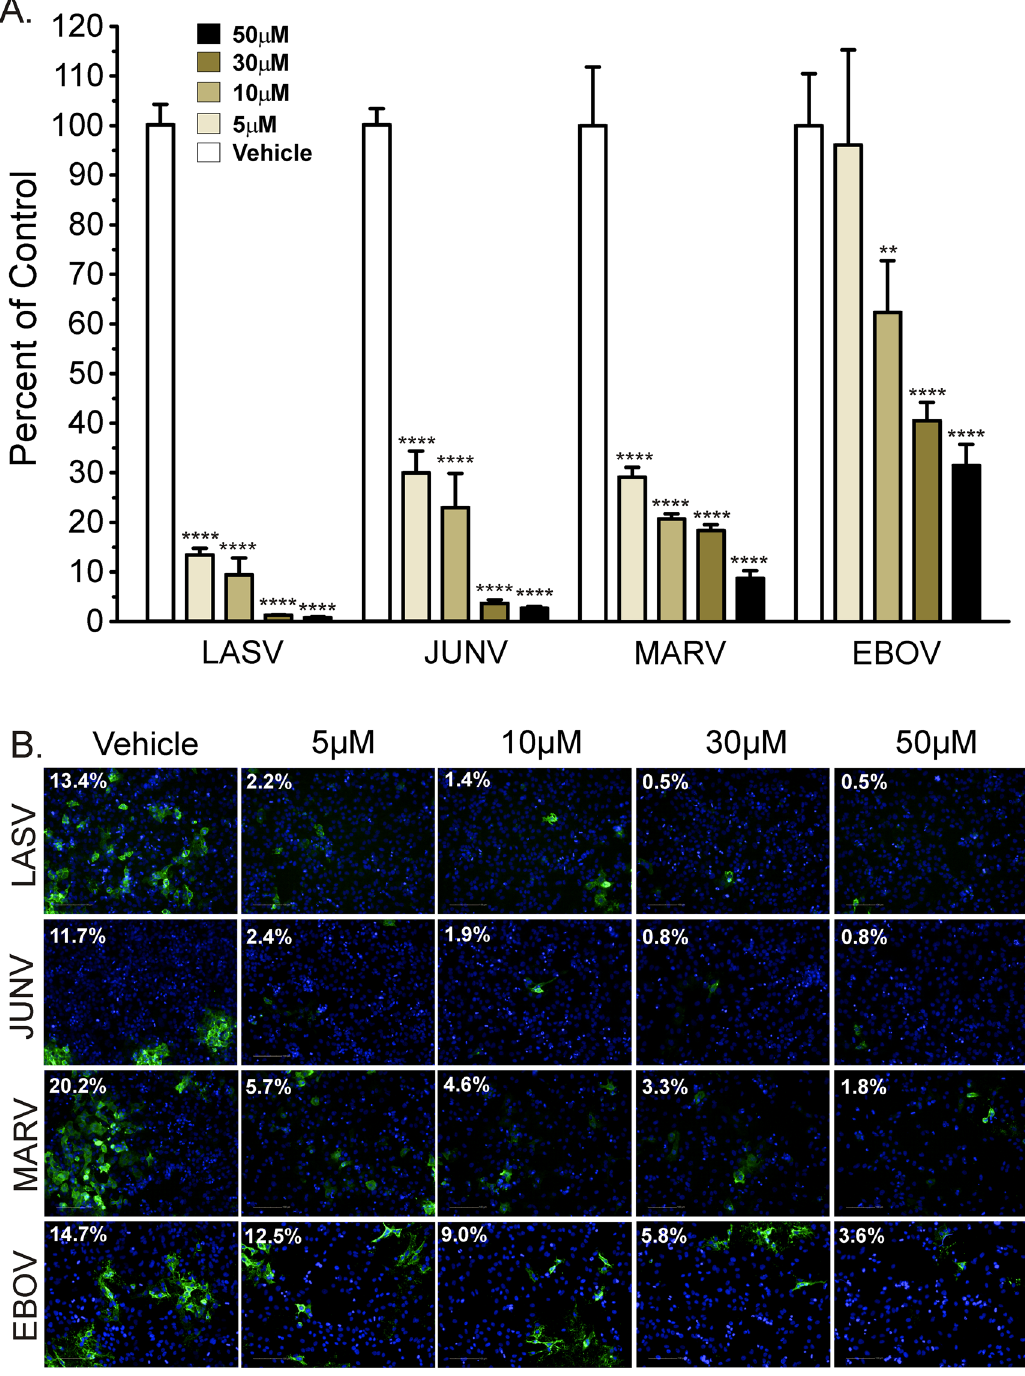
Fig 7. Synta66 inhibits egress of authentic filoviruses and arenaviruses. A . HeLa cells were infected with LASV (MOI 0.01), JUNV (MOI 0.1), MARV (MOI 0.1), or EBOV (MOI 0.1) and treated with Synta66 at indicated concentrations. Cellular virus levels were detected by immunofluorescence staining of fixed cells at 72 (LASV, JUNV) or 96 (MARV, EBOV) hours post infection with virus specific antibodies. The percent of cells infected (relative to total cells) was determined using Harmony High Content Imaging and Analysis software (PerkinElmer). Data is expressed relative to vehicle (DMSO) control treated cells for each virus. The percent of infected cells for vehicle control treatment was as follows (LASV = 12% ± 2.69%, JUNV = 9% ± 1.11%, MARV = 20% ± 1.92%, EBOV = 15% ± 1.55%). Error bars indicate standard error of mean (SEM) and statistical significance was determined by two way ANOVA with Bonferroni multiple comparisons ( ** p < 0.01, **** p < 0.0001). B . Representative images from a single live virus experiment demonstrate Synta66 dose (0, 5, 10, 30, 50 μ M) dependent inhibition of virus spread. For each condition, respective viruses were detected with virus specific antibodies (green). The value